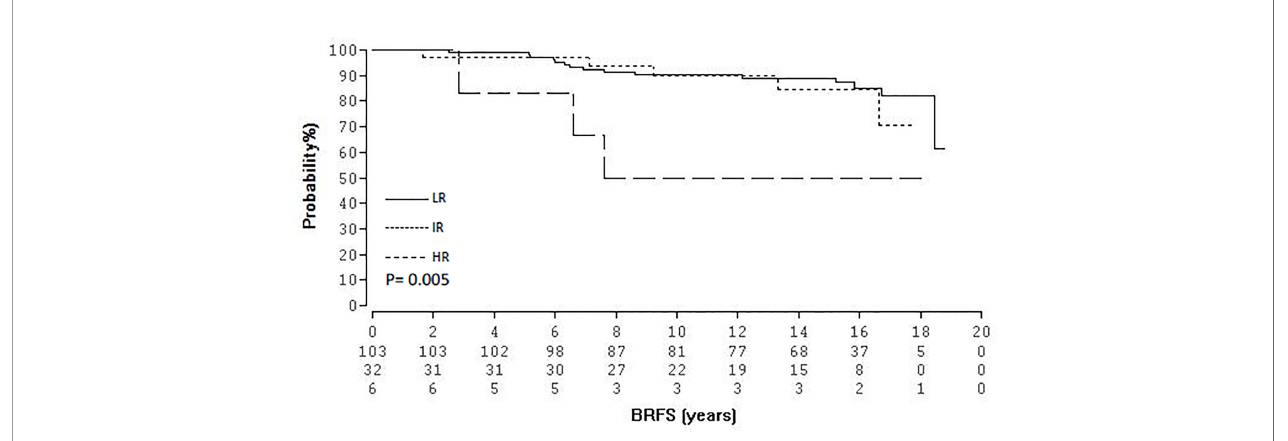
FIGURE 2 | Kaplan-Meier survival curves of BRFS according to the D ’ Amico classi fi